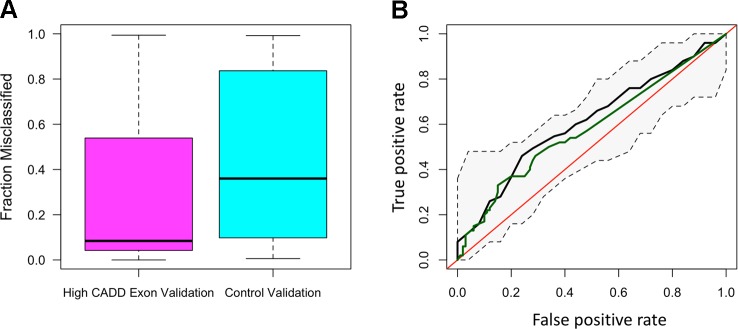
The random forest high Combined Annotation-Dependent Depletion (CADD) exon model is predictive of late aging status in the validation cohort and outperforms smoking as a predictor of aging. (A) Boxplots of the fraction of misclassified patient samples based on the random forest high CADD exon model (magenta) and the control random forest model (shuffled dataset) (teal). (B) Receiver-operating characteristic curve of the mean area under the curve (AUC) resulting from the random forest high CADD exon model (black) with confidence intervals in the discovery cohort and the AUC resulting from smoking status as a sole predictor of early versus late aging (green).